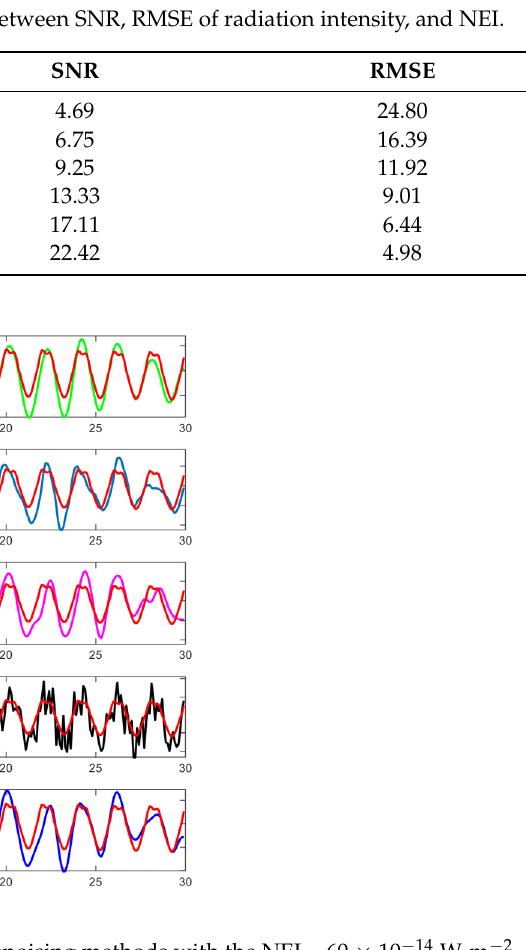
Figure 12. Denoising signal of different denoising methods with the NEI = 60 × 10 - 14 W·m -2 .